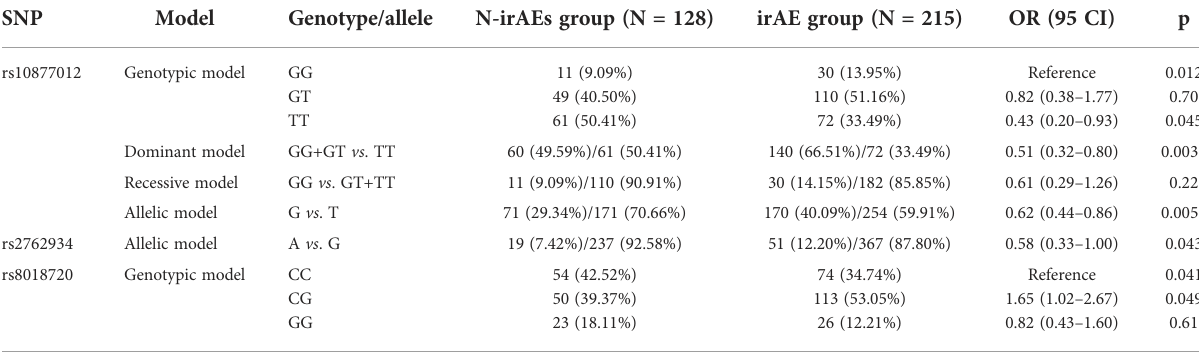
TABLE 5 SNPs signi fi cantly associated with the development of irAEs.